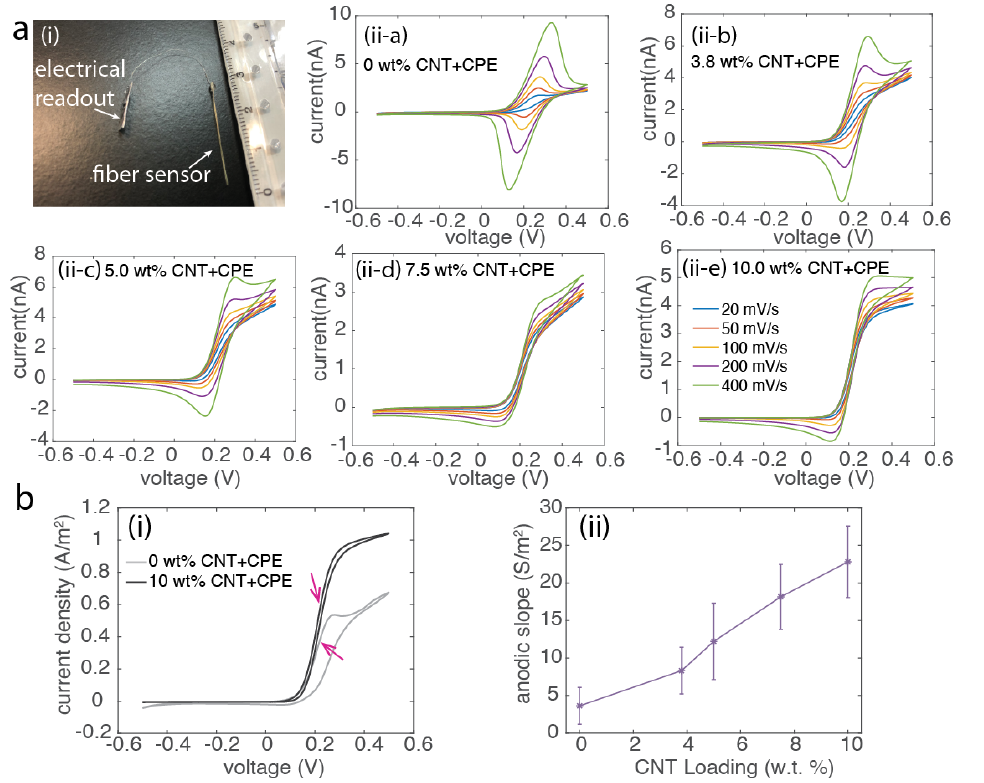
Figure 3. The electrochemical characterization of the CNT composite fibers. ( a ) Photograph of the fiber-based sensor in ( i ). ( ii ) The representative cyclic voltammograms (CV) of CNT nanocomposite fibers with varied scanning rates of 20 mV/s, 50 mV/s, 100 mV/s, 200 mV/s, and 400 mV/s, performed in 1 mM FcMeOH solutions. ( b ) The conductance per area of the electrode surface calculated based on the slope of the CV normalized by the electrode area in ( ii ). The representative CV curves obtained at 20 mV/s, a speed that all loadings of CNT composite fiber can achieve steady state. Measurements were performed across different samples (N ≥